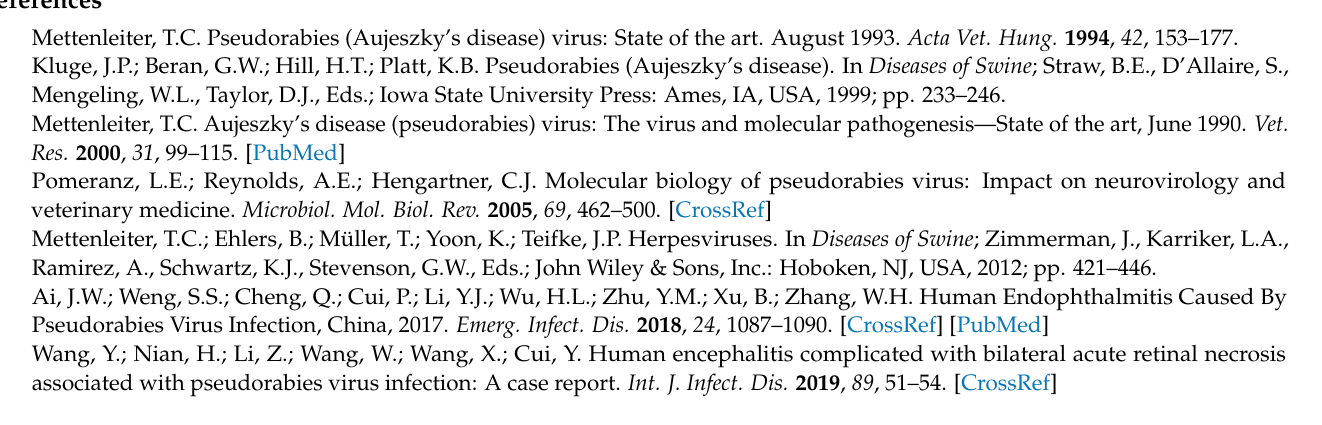
PRV strains used in this study. Table S3. RDP results summary. Table S4. Recombination events Table S6. Location of gapped regions in each newly sequenced PRV